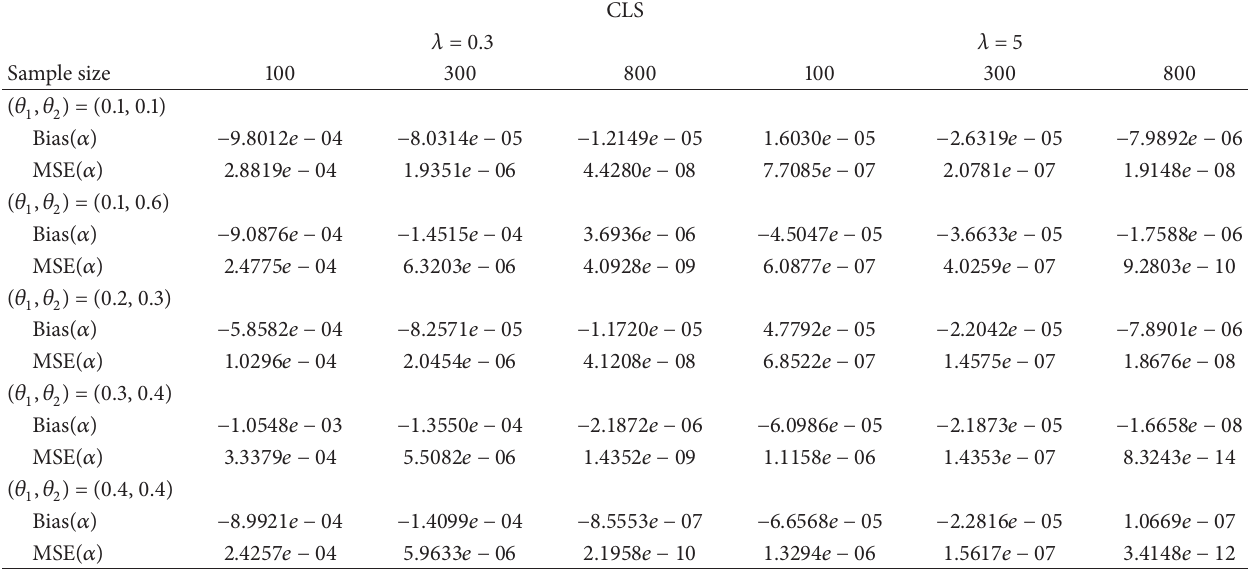
Table 2: Bias and MSE results of 𝛼 for NSINARMA(1,2) model.